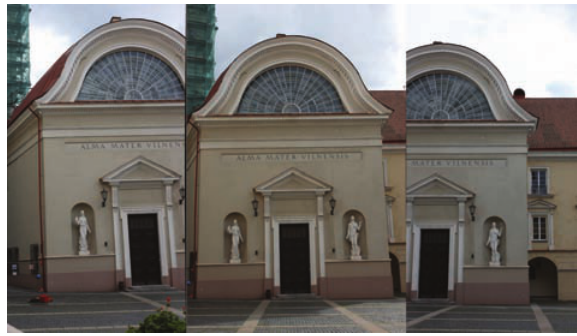
Fig. 1. Three overlapping images (P15-P12-P18) The images were taken using the Canon EOS 1D Mark III professional digital camera. The characteristics are listed in Table 1. Table 1. Characteristics of the Canon EOS 1D Mark III digital